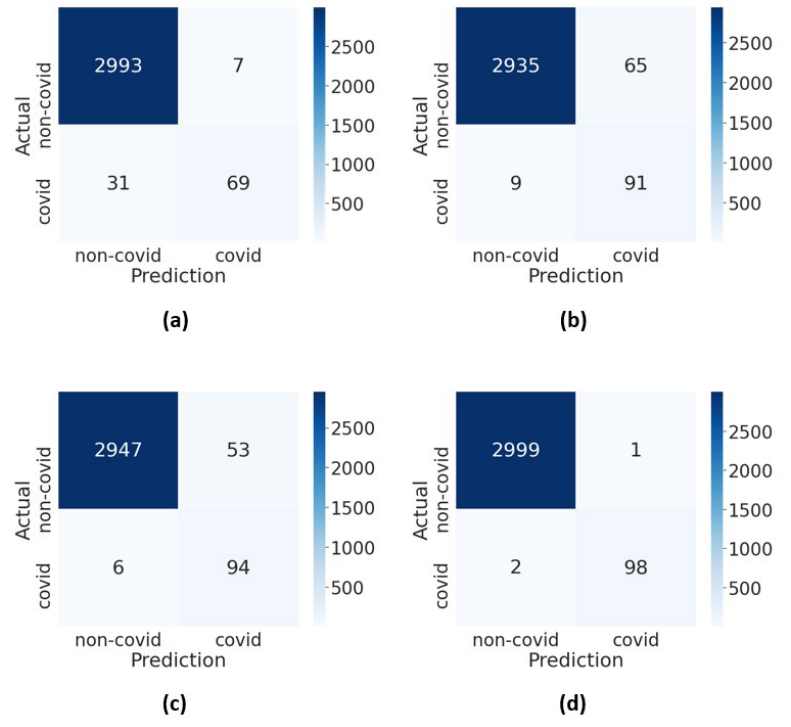
Figure 9. The confusion matrices of DensetNet201 with enhancements: ( a ) DenseNet201 with data augmentation, ( b ) DenseNet201 with data augmentation and adjusted class weights, ( c ) DenseNet201 with data augmentation, adjusted class weights and early stopping and ( d ) DenseNet201 with data augmentation, adjusted class weights, early stopping and fine-tuning. Table 5. The performance of DenseNet201 with different enhancements (DA = data augmentation, CW = adjusted class weights, ES = early stopping and FT =